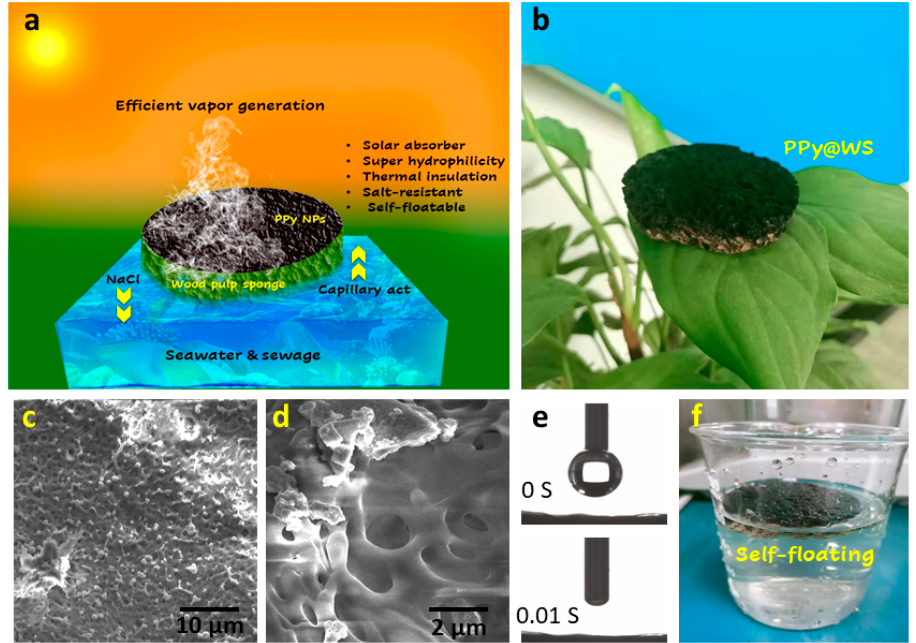
Figure 2. ( a ) Schematic illustration of self ‐ floatable and biodegradable in situ polymerized solar evaporator (PPy@WS) for efficient seawater desalination along with heavy metal ions rejection. ( b ) Photograph of exceptional lightweight PPy@WS solar evaporator stands alone over the leaf. ( c , d ) Morphologies of bare surface wood pulp sponge and in situ polymerized. ( e ) The contact angle for the super hydrophilic nature of water channels. ( f ) Self ‐ floating PPy@WS solar